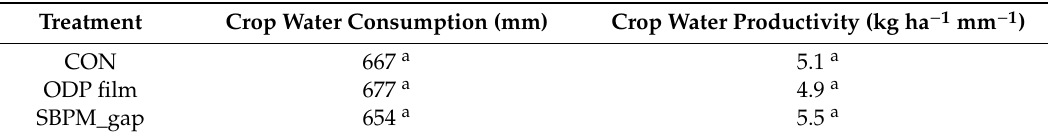
Table 1. The comparison of crop water consumption and crop water productivity of cotton grown on plots treated with sprayable biodegradable polymer membrane (SBPM), oxo-degradable plastic (ODP) mulch film, and a control plot with no mulch (CON) during the 2015 / 16 season at the ACRI field site ( n = 9 plots).